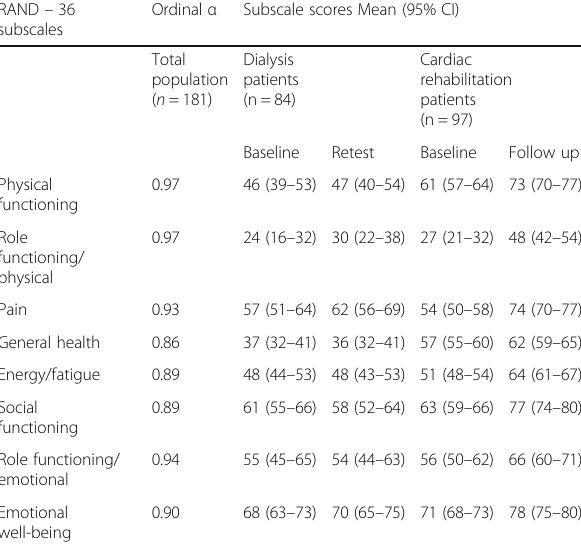
Table 3 Ordinal coefficient alpha and RAND-36 subscale scores for the two patient